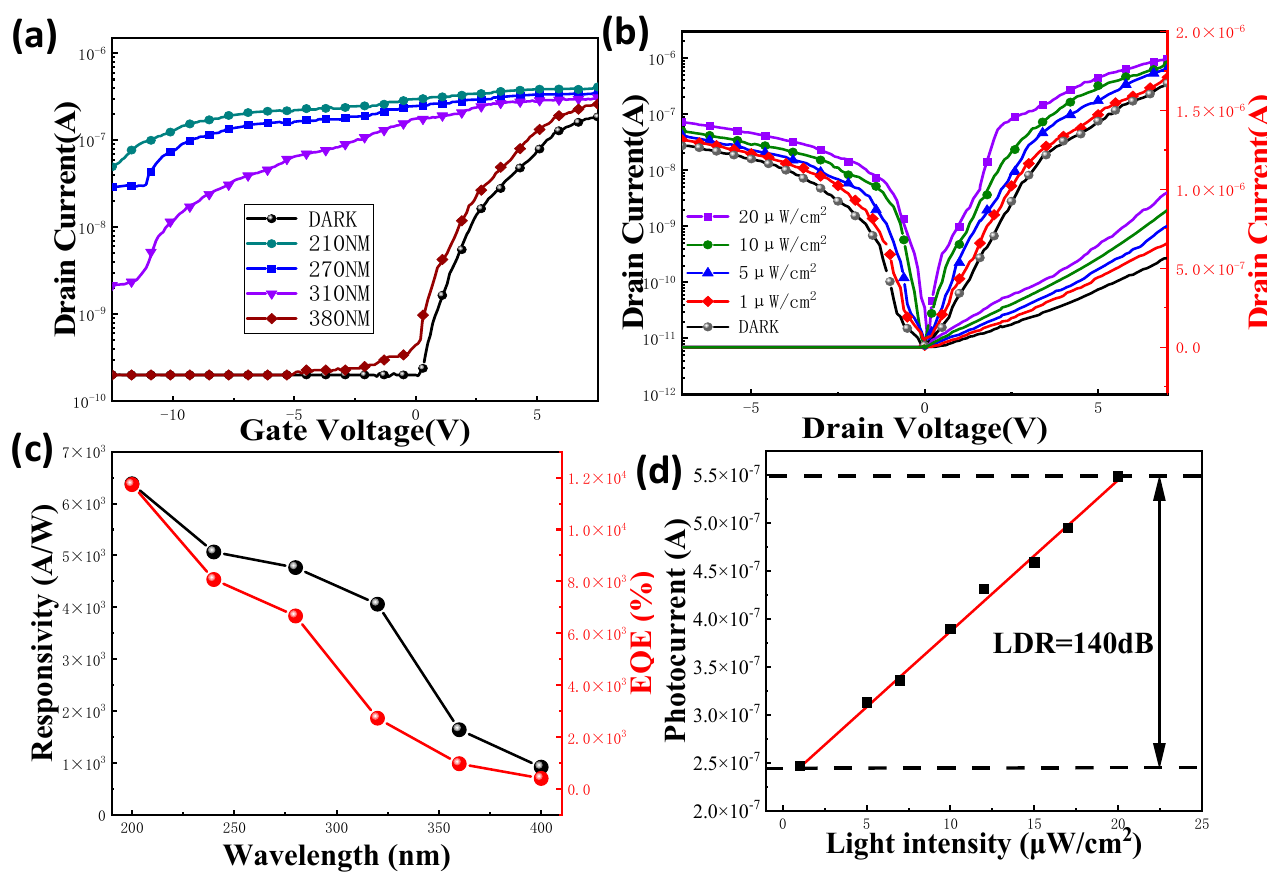
Figure 2. ( a ) I D -V G graphics for the nanowire-PT at various UV wavelengths in the ultraviolet band (V DS = 5 V); ( b ) at varied UV wavelengths, the density of the effective photo-induced carriers stored inside nanowire-PT; ( c ) EQE and responsivity in the UV band; ( d ) photocurrent in relation to incoming light power at wavelengths under 270 nm.